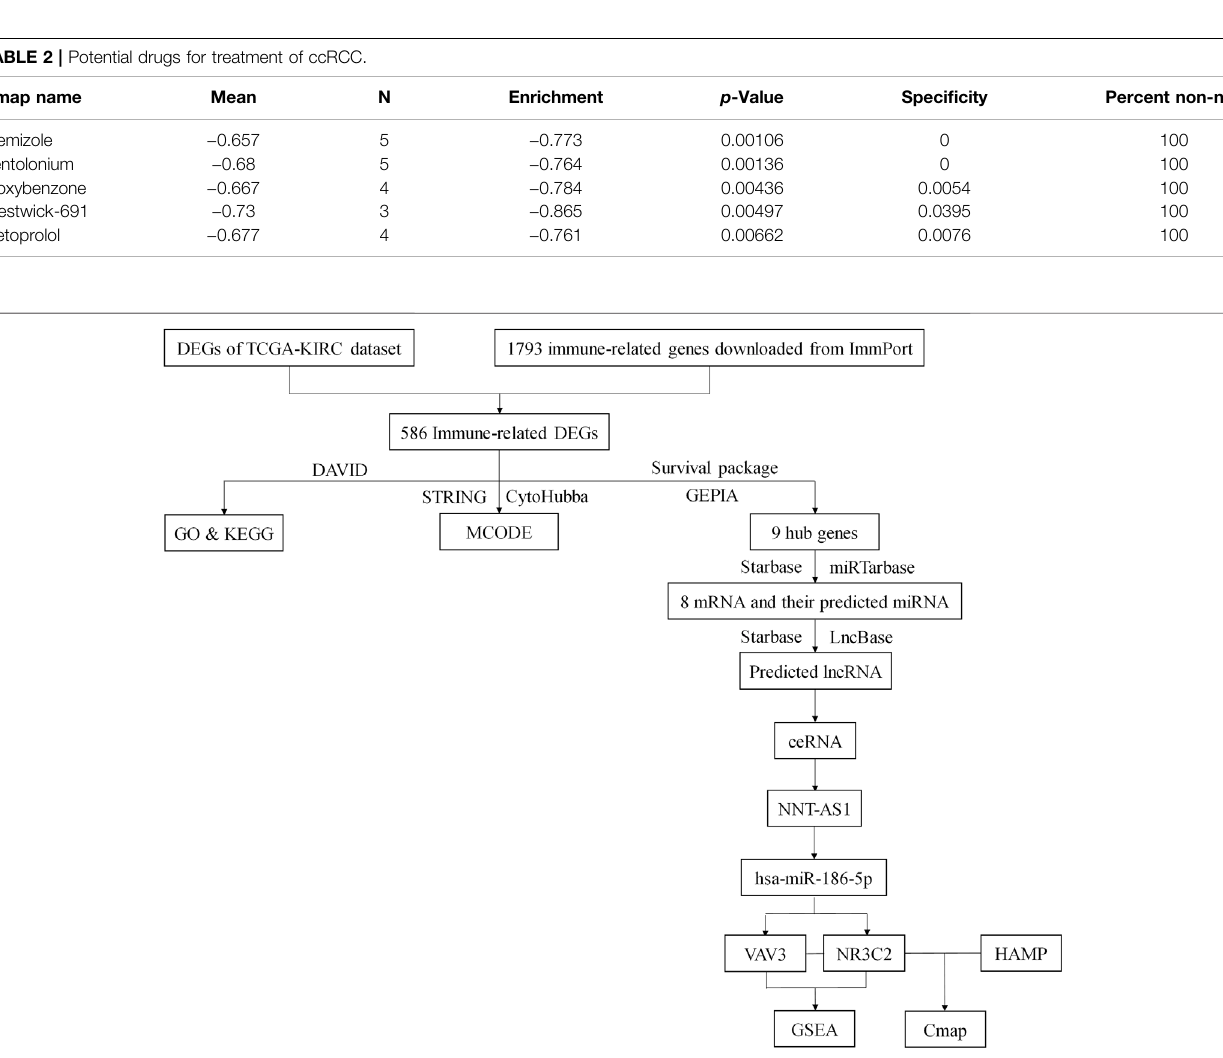
FIGURE 10 | Flow chart of this study. DEGs, differentially expressed genes; TCGA, The Cancer Genome Atlas; KIRC, Kidney Clear Cell Carcinoma; DAVID, The Database for Annotation, Visualization, and Integrated Discovery; GO, Gene Ontology; KEGG, Kyoto Encyclopedia of Genes and Genomes.